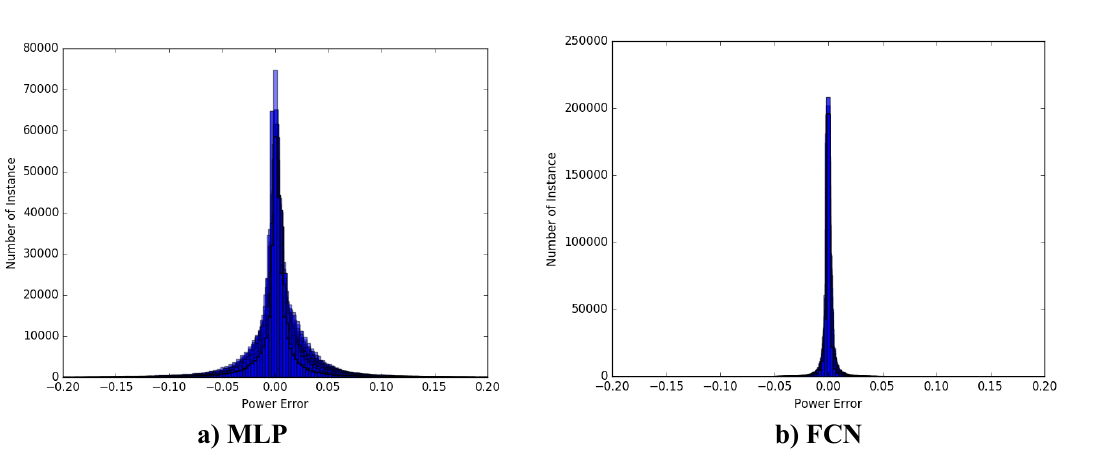
Figure 5. The absolute error distribution of the validation data for FCN and MPL